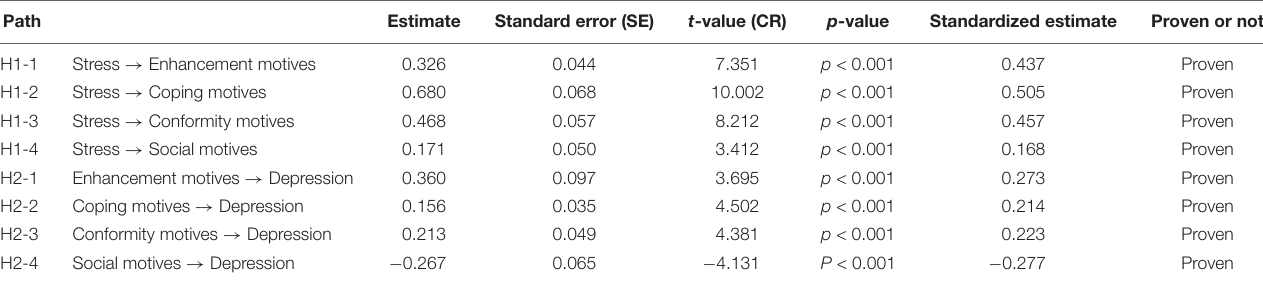
TABLE 4 | Hypothesis